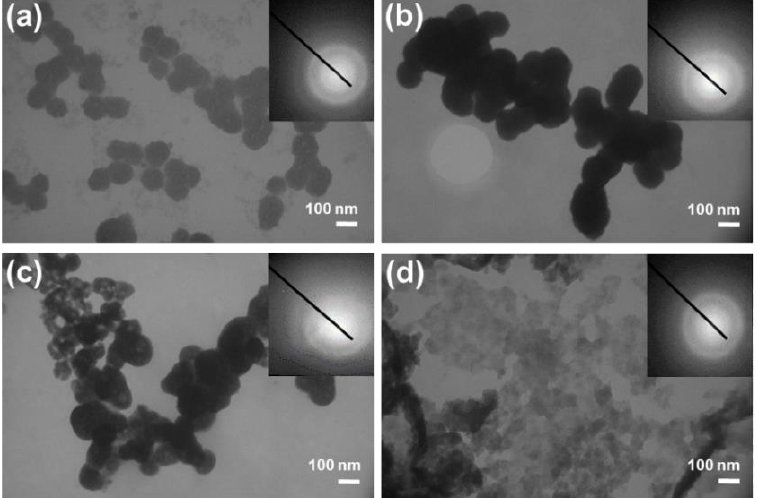
Figure 2. TEM micrographs and corresponding SAED patterns (insets in the figures) of precipitates formed in ( a ) control system and in the presence of ( b ) DMPC, ( c ) DMPS, and ( d ) EPC liposomes. c i (Ca) = c i (PO 4 ) = 3.5 mmol dm −3 ; γ (lipid) = 25.0 ppm; pH i = 7.4, ϑ /°C = 25 ± 0.1; after 30 min aging time.